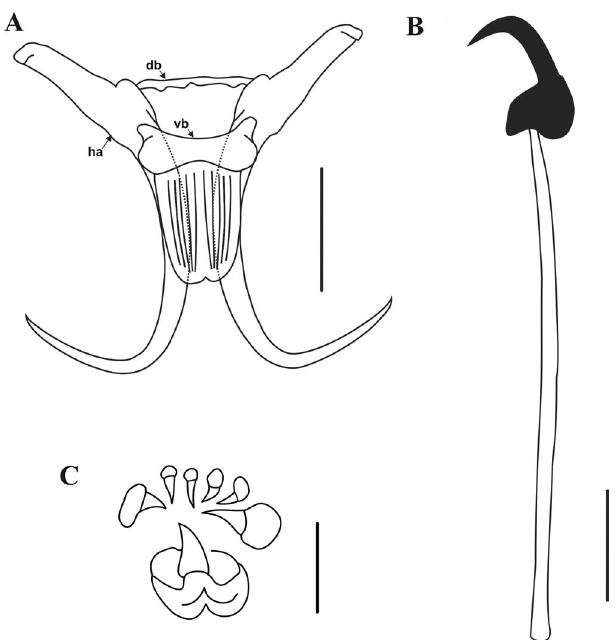
Figure 2. Line drawings of the haptoral sclerites and MCO of Gyrodactylus magadiensis n. sp. from Alcolapia grahami in Lake Magadi, Kenya. (A) Haptoral sclerites with hamulus (ha), dorsal bar (db), and ventral bar (vb); (B) marginal hook; (C) male copulatory organ (MCO). Scale bars – (A) 20 l m; (B and C) 5 l